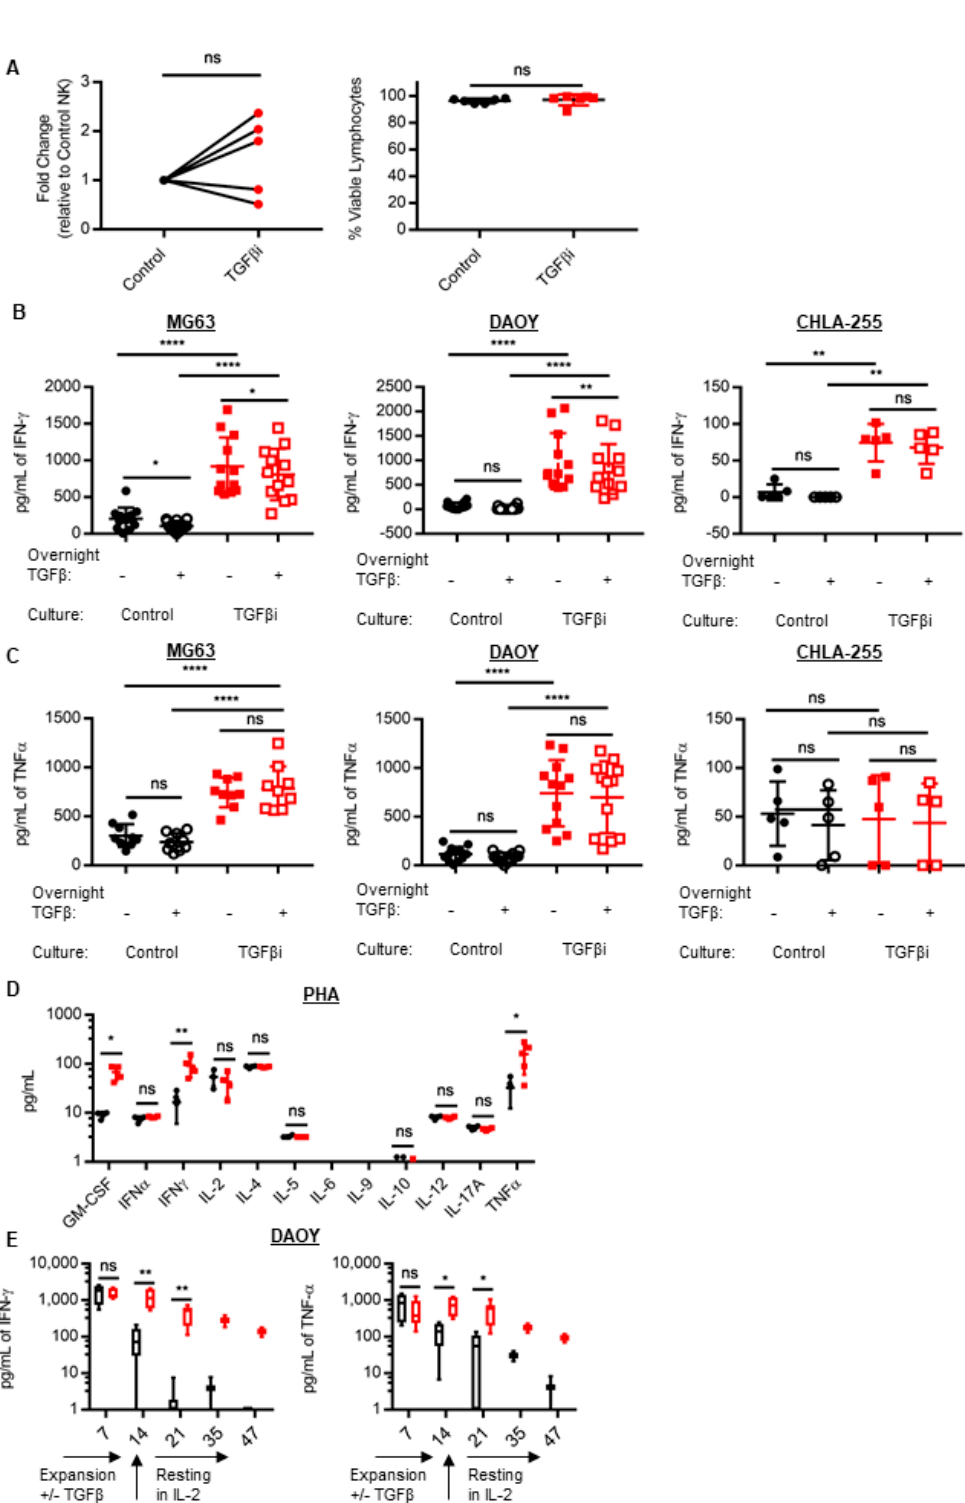
Figure 1. The chronic stimulation by transforming growth factor-beta (TGF β ) during natural killer (NK) cell expansion and activation generates NK cells with increased cytokine secretion. NK cells were cultured for 14 days in 50 IU/mL IL-2 or 50 IU/mL IL-2 plus 10 ng/mL TGF β (TGF β i) with a weekly stimulation with K562 mbIL-21 feeder cells. ( A ) NK cell proliferation was compared by determining the fold change of control and TGF β i total NK (CD3 − /CD56 + and CD3 − /CD16 + ) cells at Day 14 and the viability of total cells was determined using Tonbo Viability dye. ( B ) After 14 days of